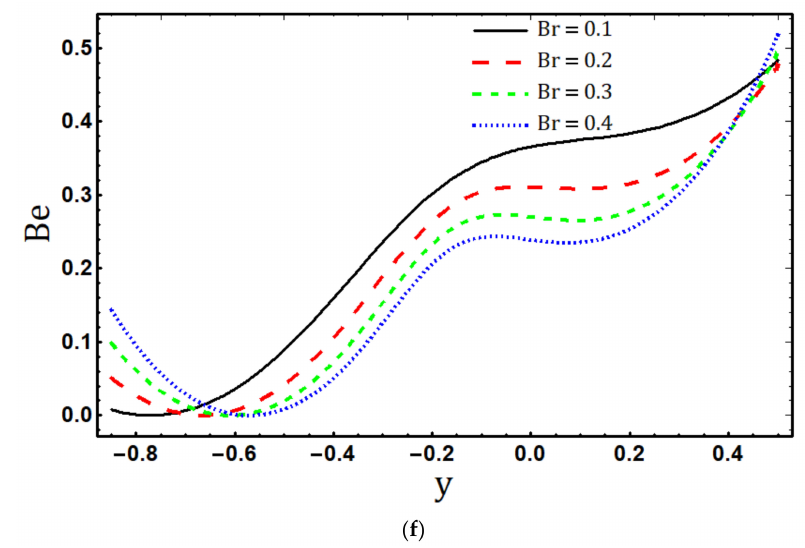
Figure 6. ( a ): Effects of Ha on Be , while other parameters are b 1 = 0.3, b 2 = 0.5, x = 0.5, l =